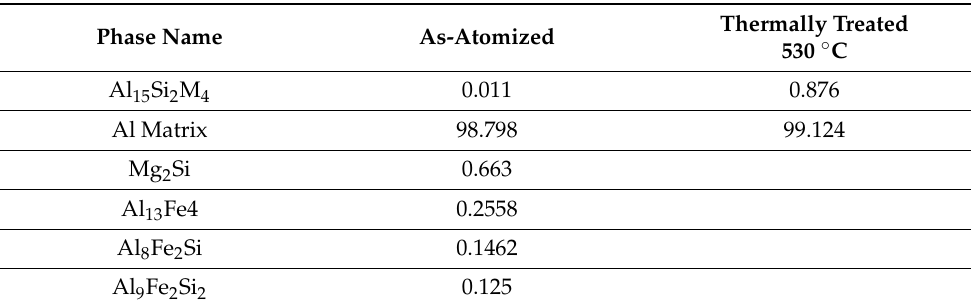
Figure 8. ( a ) Scheil solidification diagram and ( b ) equilibrium diagram for Al 6061 powder composition using ThermoCalc database TCAL8, ( c ) equilibrium diagram for Al 6061 powder composition using ThermoCalc database TCAL5. Table 2. Volume percentage of secondary phases predicted by ThermoCalc for the as-atomized and thermally treated powder conditions.